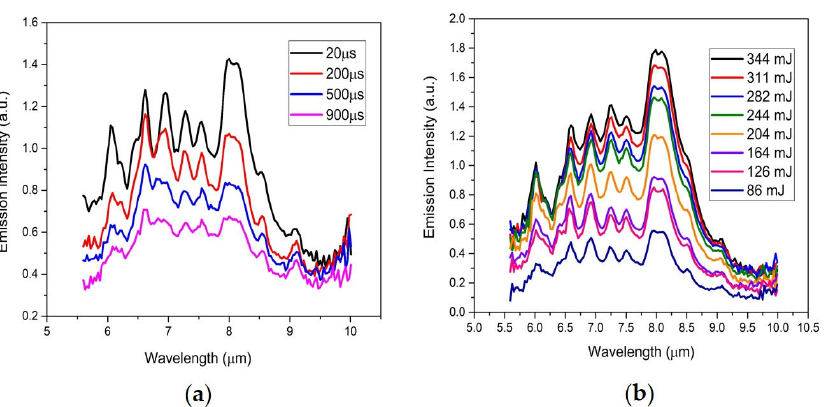
Figure 5. ( a ) LWIR LIBS spectrum of an acetaminophen tablet measured at a delay time of 20 µs, 200 µs, 500 µs, and 900 µs; ( b ) LWIR LIBS spectrum of an acetaminophen tablet measured at a delay time of 20 µs with different excitation laser pulse energies.